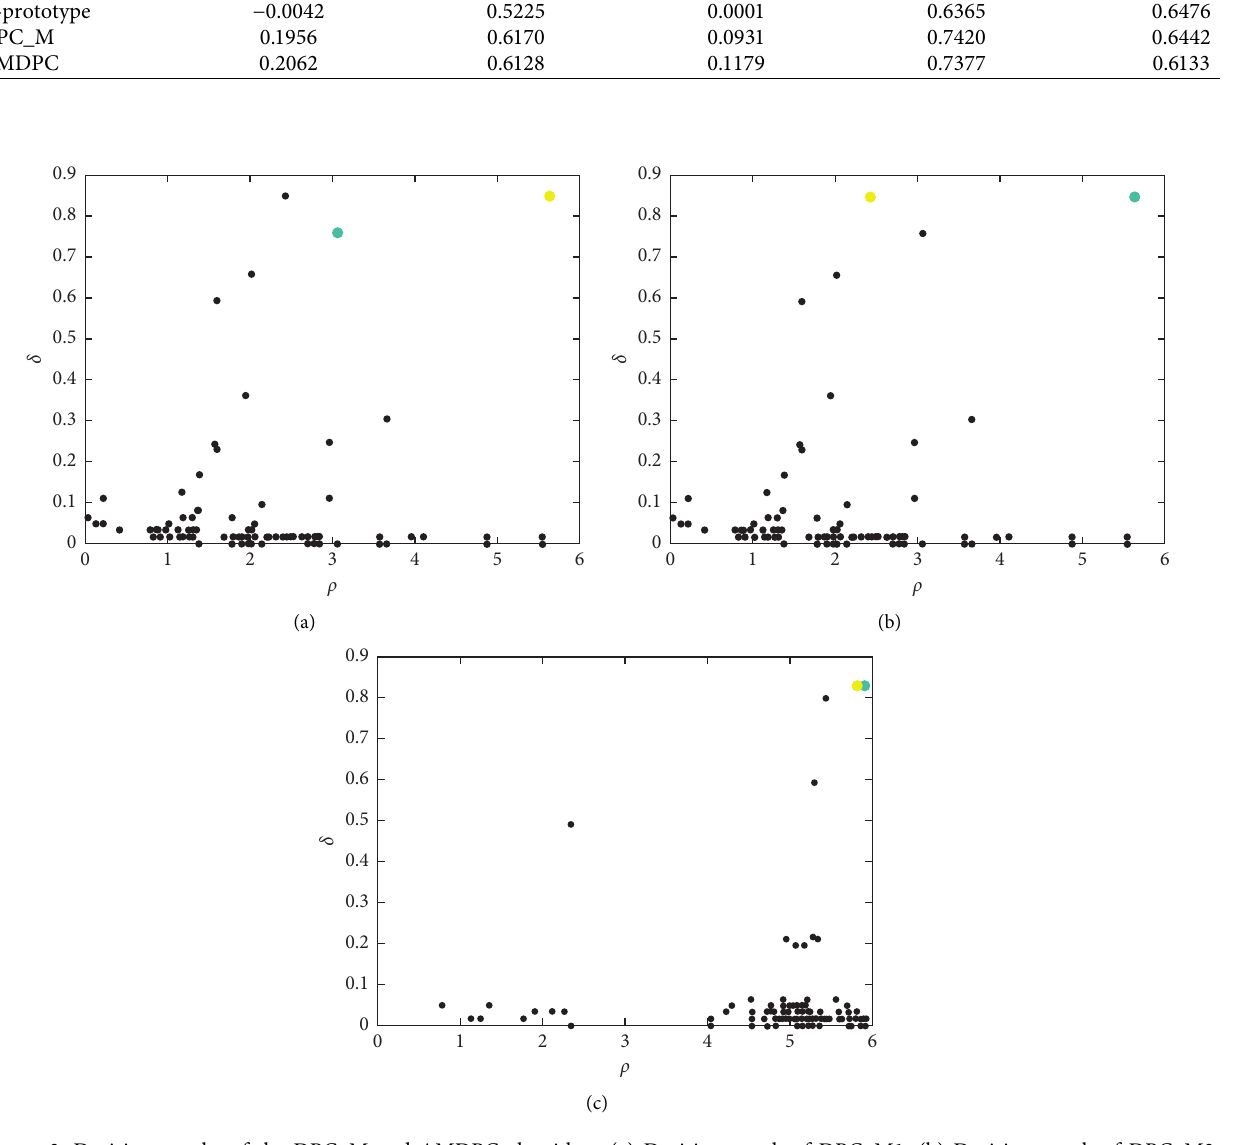
Figure 3: Decision graphs of the DPC_M and AMDPC algorithm. (a) Decision graph of DPC_M1. (b) Decision graph of DPC_M2. (c) Decision graph of